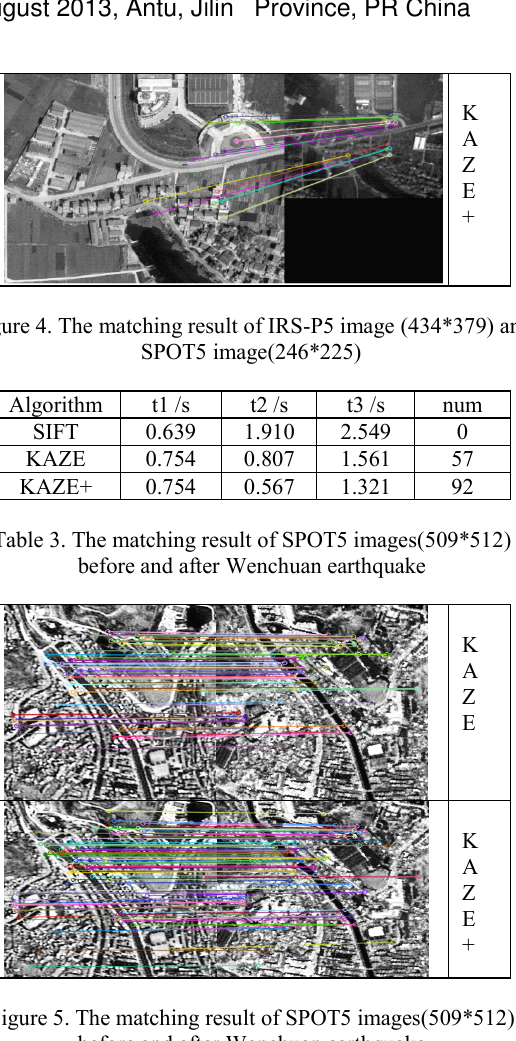
Figure 5. The matching result of SPOT5 images(509*512) before and after Wenchuan